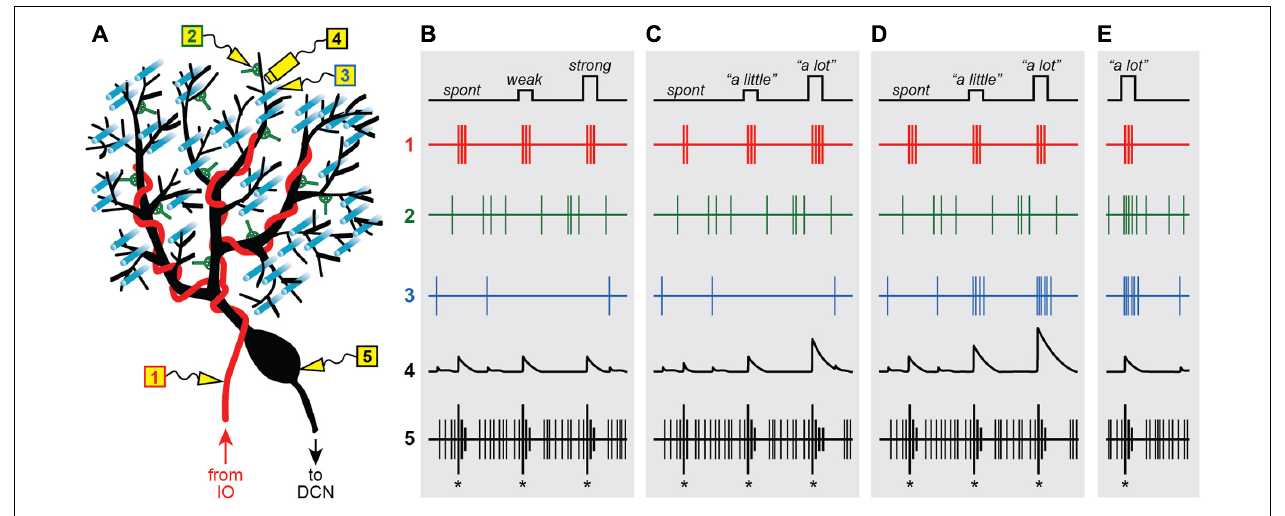
locations shown in (A) , under four different scenarios: when all climbing fiber signals are “all-or-nothing” whether firing is spontaneous (spont) or when the strength of stimulation in the inferior olive is weak or strong (B) , when instructive signals to lift the foot “a little” or “a lot” influence the number of spikes in the climbing fiber burst (C) , or when the instructive signals activate the climbing fiber simultaneously with parallel fiber inputs (D) and input from the molecular layer interneurons (E)